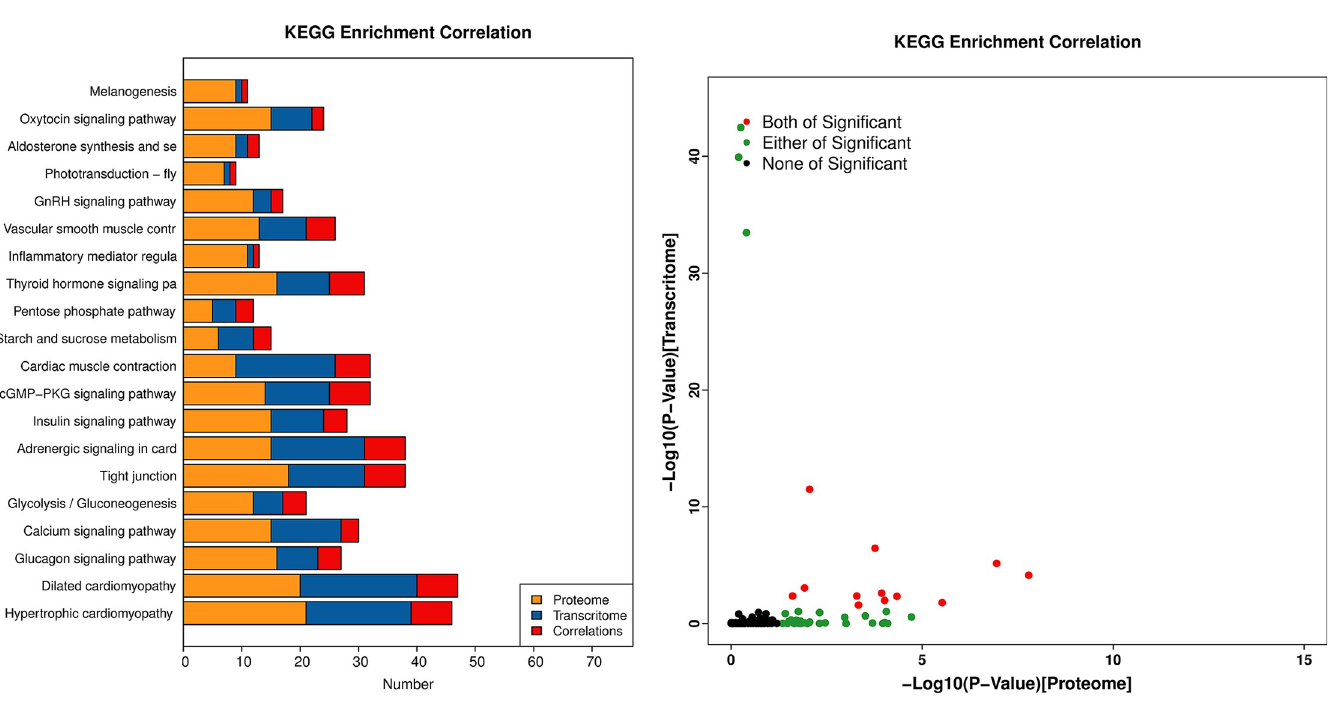
Fig 7. Correlation of KEGG enrichment between transcriptome and proteome. (A) Number of KEGG enrichment correlations between transcriptome and proteome. (B) The overview scatter diagram of KEGG enrichment correlations between the transcript levels and protein levels of genes.